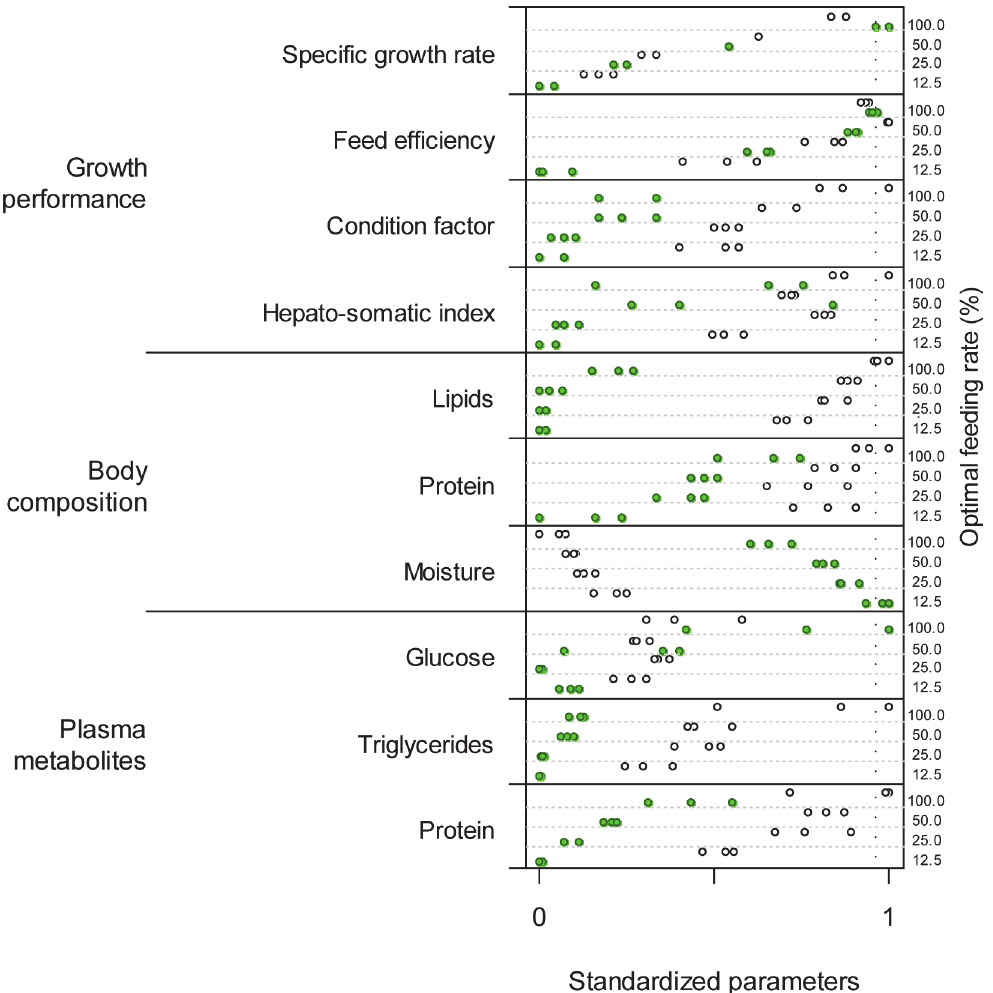
Fig 2. Standardized values (0 to 1) of biological responses to nutritional changes. Green and white dots denote green and white sturgeon, respectively. For each biological parameter (y-axis), fishes were challenged with four levels of feeding rate (12.5, 25, 50, 100%; right y-axis). Three observations were collected per FR level per